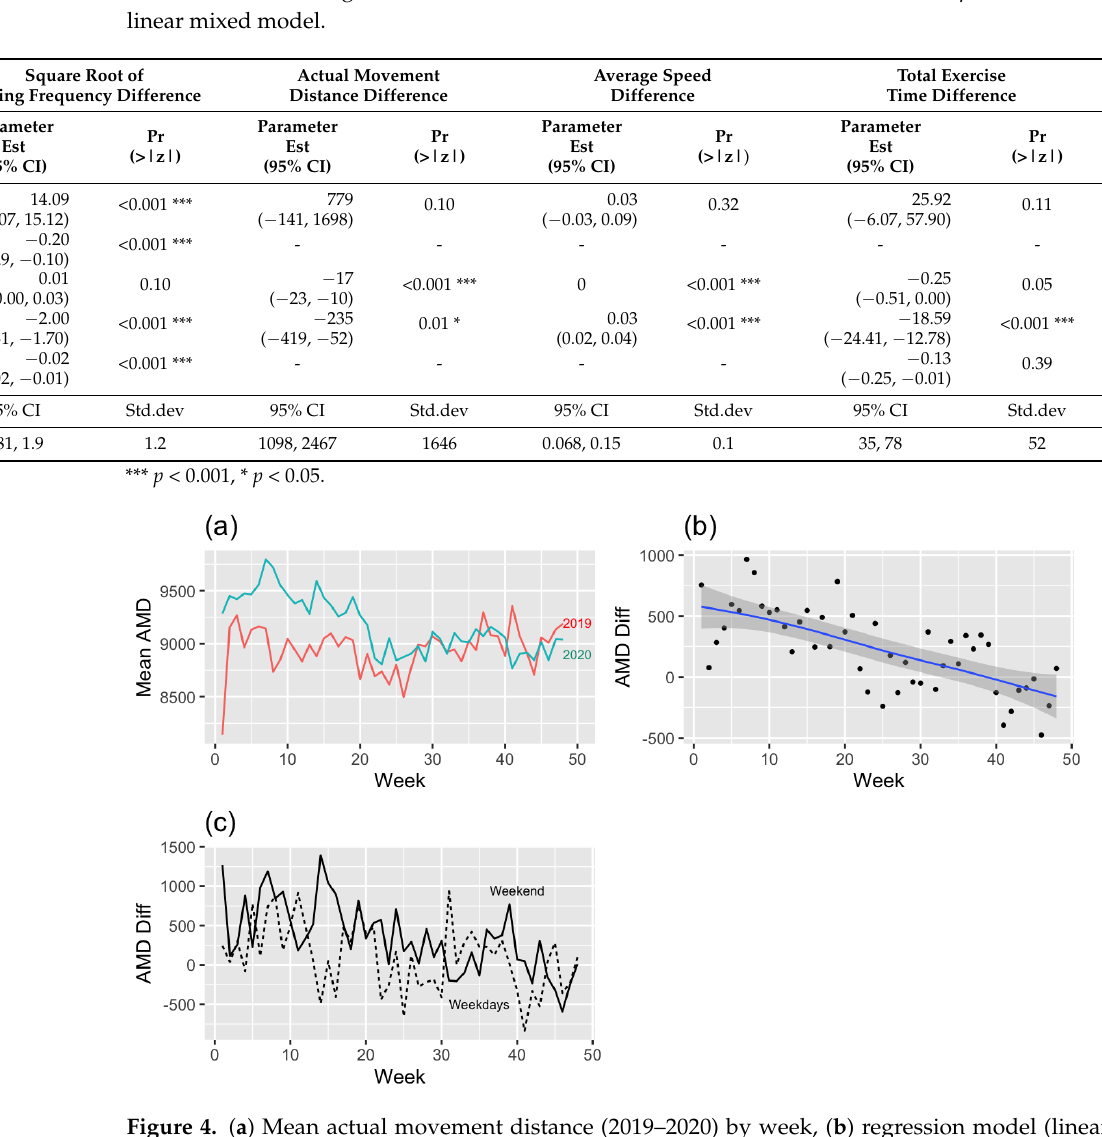
Figure 4. ( a ) Mean actual movement distance (2019–2020) by week, ( b ) regression model (linear mixed model) graph of actual movement distance difference (2019–2020), and ( c ) difference of actual movement distance of weekdays or